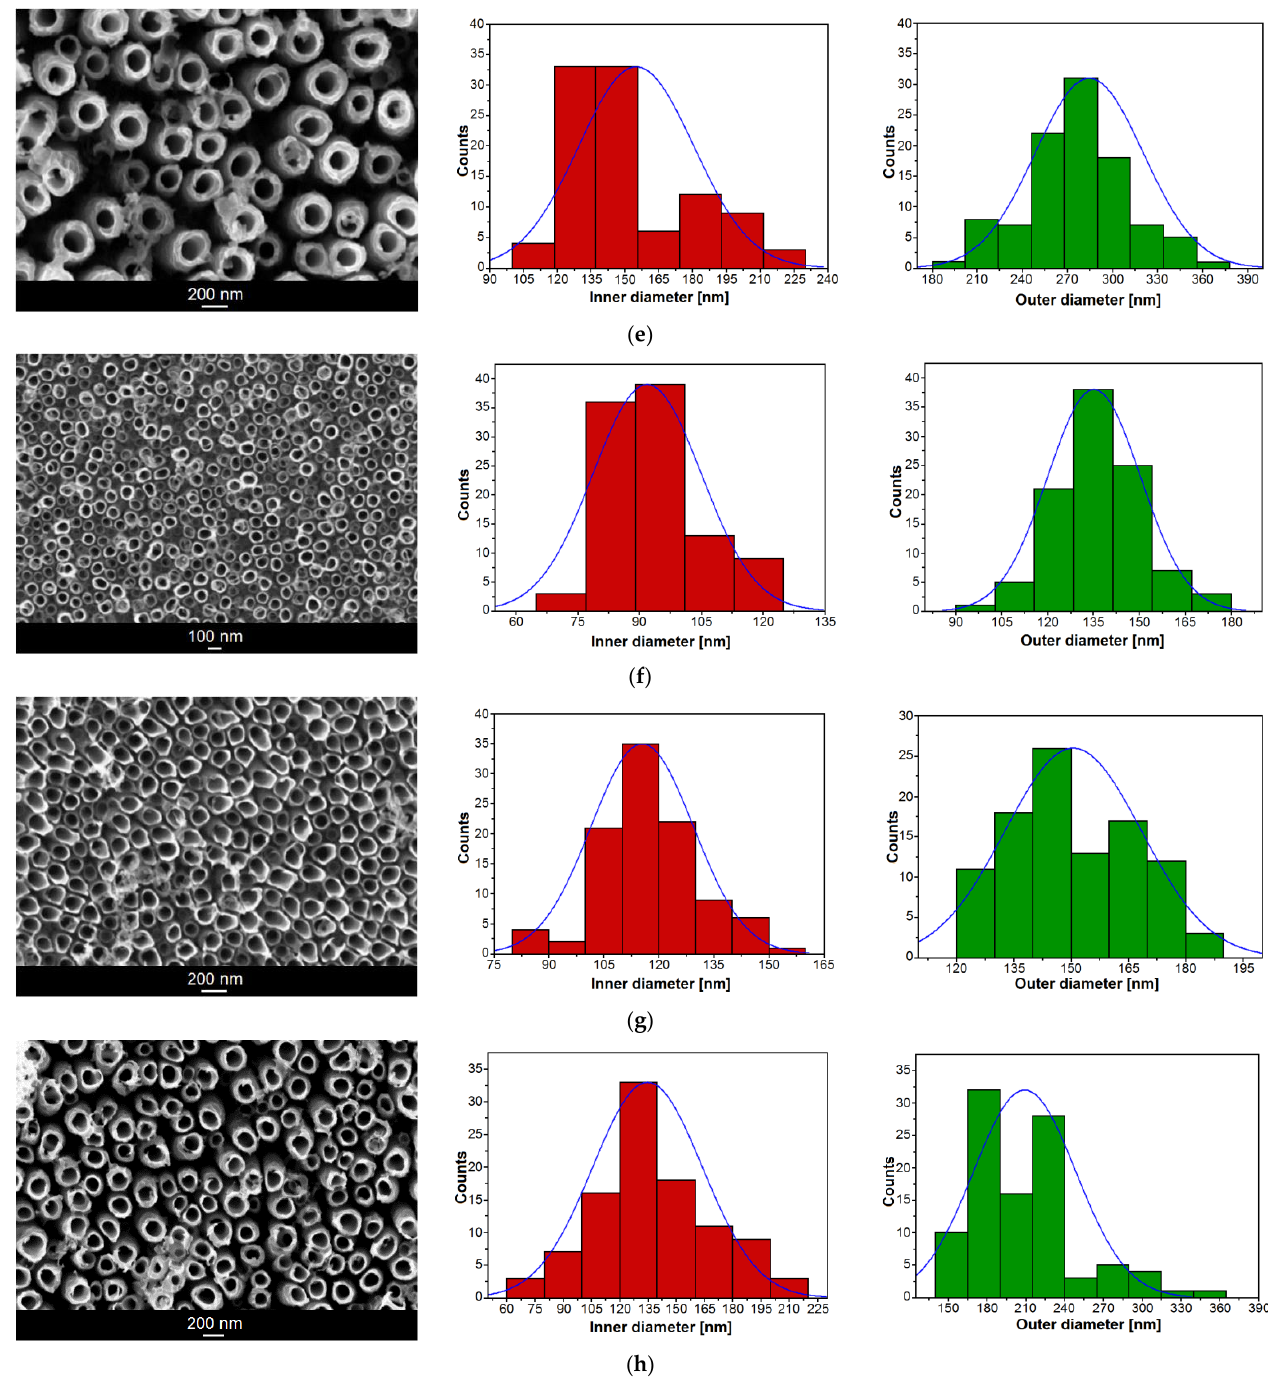
Figure 2. SEM image of the microstructure of oxide nanotube (ONT) layer formed on the Ti – 6Al – 7Nb alloy in 1 M EG + 0.2 M NH 4 F electrolyte under anodizing conditions with the corresponding histogram of inner and outer diameter distributions of ONTs: ( a ) 15 V for 60 min; ( b ) 30 V for 60 min; ( c ) 50 V for 60 min; ( d ) 70 V for 60 min; ( e ) 100 V for 60 min; ( f ) 30 V for 45 min; ( g ) 50 V for 30 min; ( h ) 70 V for 20 min. Gaussian fitting curve is marked as blue solid line.